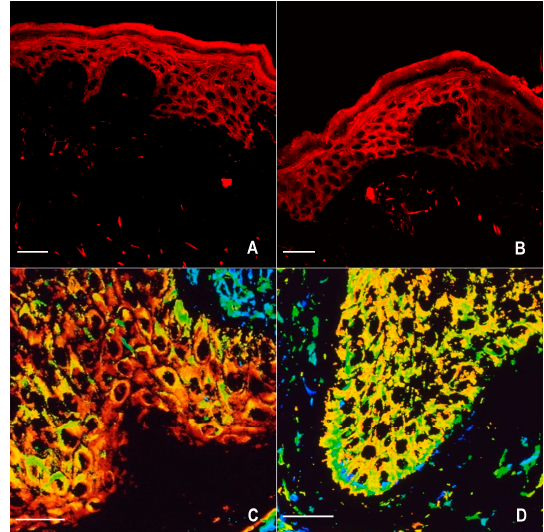
Figure 2. Inflammatory/lesional vitiligo skin: immunofluorescence staining of iNOS ( A , B ). Confocal image obtained in “overlay” mode showed a significant iNOS expression both in the basal and in suprabasal layer. iNOS expression was not observed in epidermal melanocytes. Argon laser (568 nm) lens 3, zoom 1, original magnification 40×. bar = 20 µm; ( C , D ) three-dimensional reconstruction obtained in depth coding mode. The colors reveal the spatial distribution (arrangement) of iNOS throughout the thickness of the section. ( A , B ) Argon laser (568 nm) lens 3, zoom 2, original magnification 40×. bar = 25 µm.